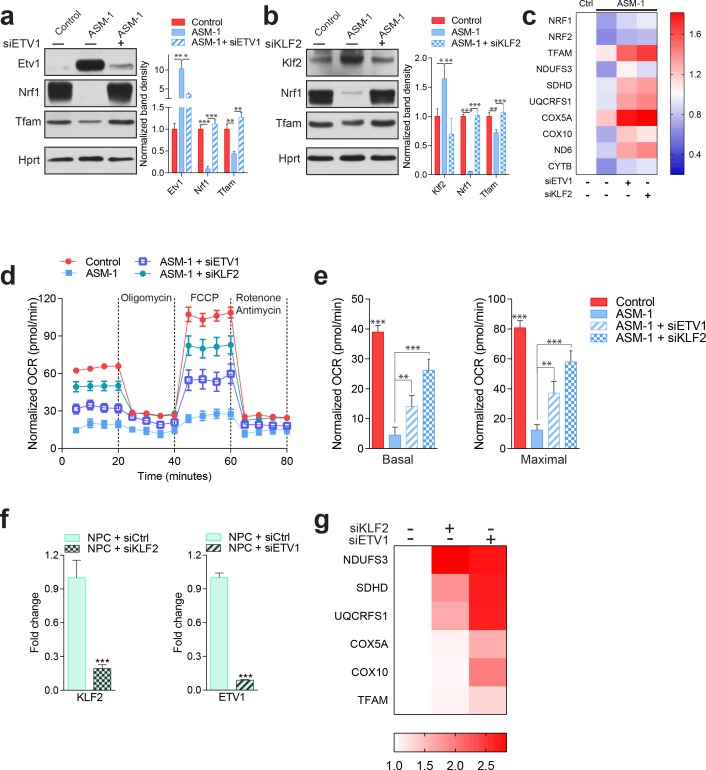
Silencing of ETV1 or KLF2 rescues mitochondrial biogenesis and function in Niemann-Pick fibroblasts.Using siRNA-mediated silencing, we knocked-down Etv1 (a) or Klf2 (b) in ASM1-deficient fibroblasts, which brought the protein levels of mitochondrial protein TFAM, and of mitochondrial biogenesis regulator NRF1 to control levels, as shown in a representative western blot of whole cell extracts, with quantification of band densities in the adjacent plots as mean ± s.em., n = 3. Scrambled siRNA was used as control in both control and ASM-deficient cells for all experiments involving ETV1 or KLF2 silencing. T-test p-values *p<0.05, **p<0.01 ***p<0.001 (c) Silencing of ETV1 or KLF2 increases the transcript levels of mitochondrial genes, as assessed by qPCR. The data is presented in a Heatmap, in which blue denotes decrease in expression compared to the control cells (white represents no change relative to the control values) and red denotes increase. Note the mostly decreased (blue) mitochondrial genes in ASM-deficient cells and their turn to red (increased expression) when ETV1 or KLF2 are silenced (n = 3). (d–e) Silencing of either Klf2 or Etv1 partially rescues the decreased basal and maximal OCR in ASM-deficient fibroblasts as measured by real time respirometry. The plot shows the mean ± s.e.m., n = 3. T-test p-values **p<0.01 and ***p<0.001. (f) Robust silencing of KLF2 or ETV1 in NPC1-deficient cells shows accordingly, significantly decreased transcript levels of KLF2 and ETV1. Graphs represent mean ± s.e.m, n = 3 with T-test p-values ***p<0.001 (g) KLF2 or ETV1 knockdowns in NPC1-deficient cells increases the transcript levels of mitochondrial genes, which is presented as a Heatmap. Note the mostly increased (red) mitochondrial genes when KLF2 or ETV1 are silenced relative to Scrambled siRNA (white) in NPC1-deficient cells (n = 3).